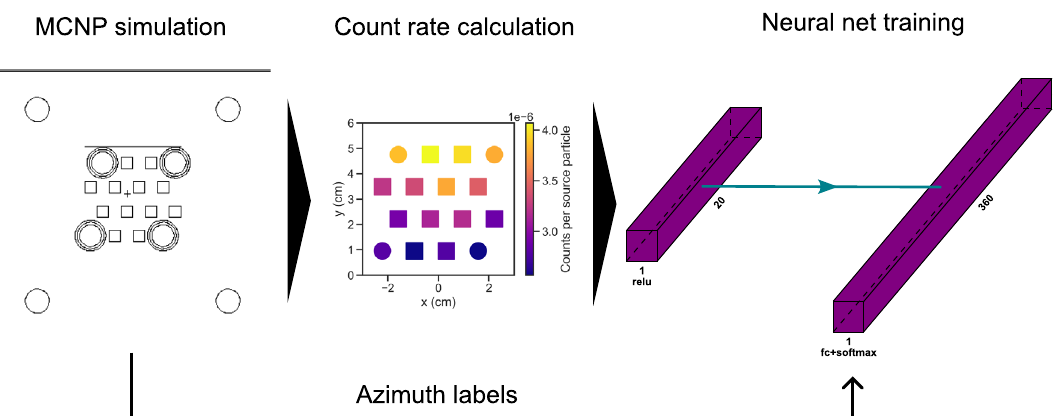
Figure 7. Overview of the training data generation for the source direction prediction using a neural net. 360 cases of a source around the detector were simulated using MCNP PoliMi, covering the azimuthal space ◦ in 1 increments. The count rates in each detector volume were then extracted alongside the known angular position of the source to create a training data set. The input nodes of the neural network correspond to the detector volumes, 12 organic glass scintillators and 8 CeBr 3 , i.e., a vector of length 20 with relu activation. The output layer of length 360 is fully connected (fc) to the input with a softmax activation, denoting the estimated probability for a source being at the index in two silicon photomultiplier (SiPM) arrays (ArrayJ-60035-64P-PCB SensL) with (6x6x0.5 mm 3 ) EJ-560 optical interfaces 3,36 for light collection. The system notably uses dual ended readout and the relative light yields per pulse top versus bottom to estimate the z-position of a given interaction 37 . The H2DPI was connected via standard BNC and LEMO cables to two CAEN V1730S digitzer boards mounted to a CAEN VME8004 powered crate. Neural network for source direction estimation. The neural network was constructed using the Ten- sorFlow 2.5 library in Python 3.8.8. Recently, the successful application of neural nets for this task was shown using arrays of NaI detectors 29,38 , or a single volume HPGe 39 . The neural network input nodes correspond to the count rates in each of the 20 detector volumes of the H2DPI. The output layer is the probability estimate for an ◦ azimuthal angle, here discretized by 1 increments into a vector of length 360. The input layer activation func- tion was set to relu, whilst the output layer relied on softmax. Training data was produced with the Monte Carlo particle transport code MCNPX-PoliMi 40 that allows for both neutron and photon transport. An explicit model of the detector and casing was created, see Fig. 7. We ◦ simulated 360 source locations, each displaced by 1 increments at 30 cm distance to the detector, to cover the